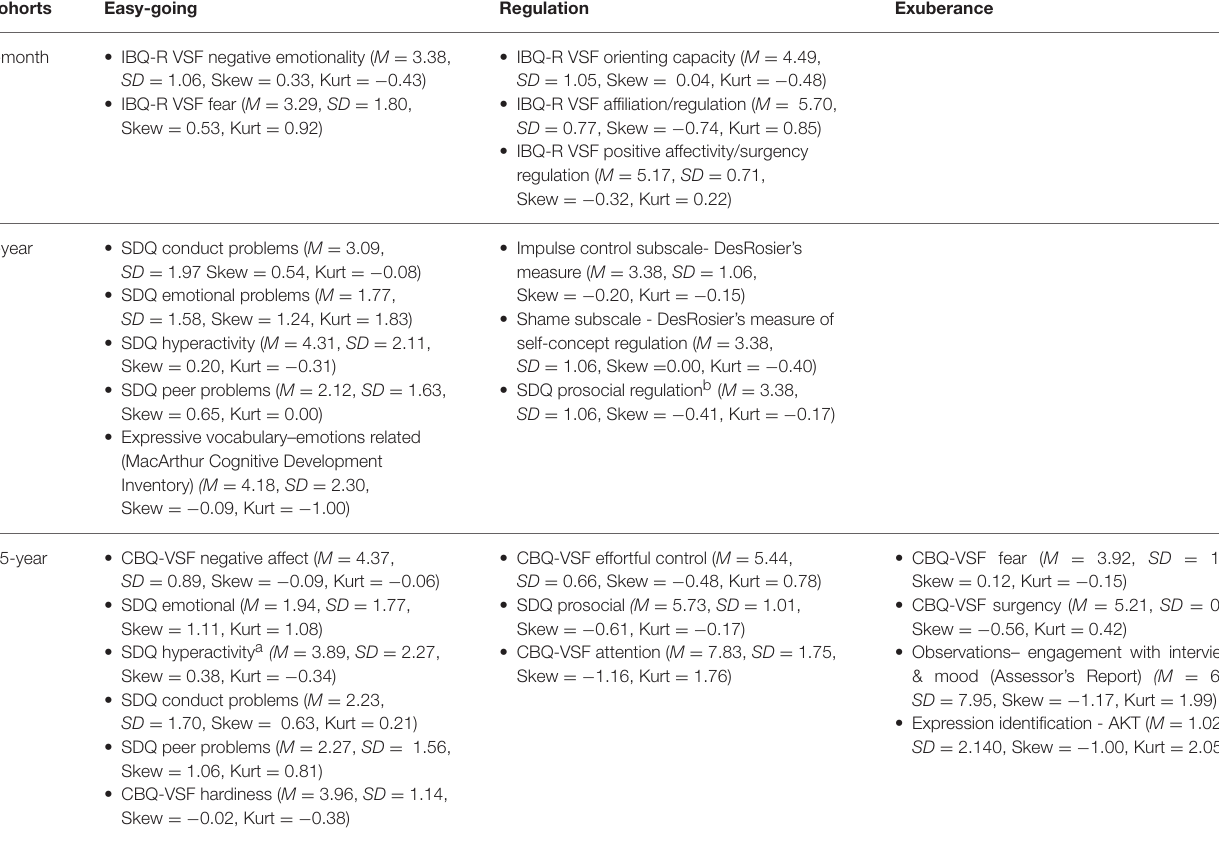
TABLE 2 | Showing the grouping of socio-emotional variables after exploratory factor analysis at each DCW and related descriptive statistics.